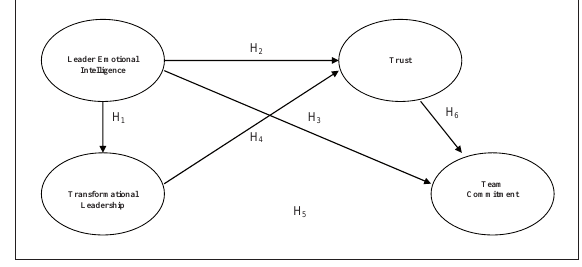
Figure 1 The Integrated Conceptual